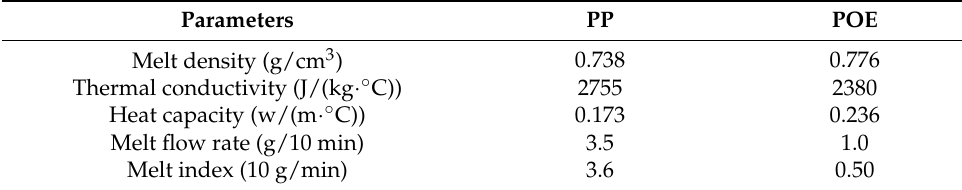
Table 4. Physical properties of PP and POE.